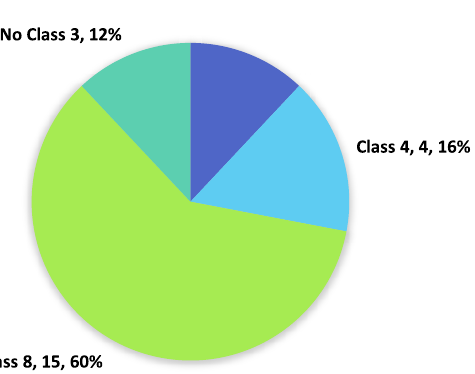
Fig. 4. Classification of putative R-genes in qLBL5 according to relevant